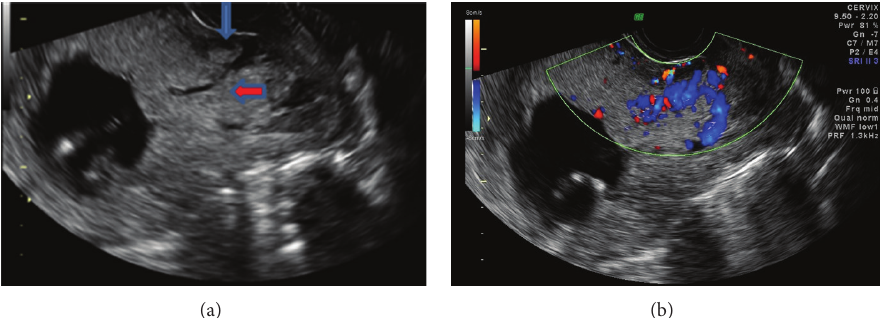
Figure 2: (a) Transvaginal scan at 13 weeks’ gestation demonstrating placental lacunae (red arrow) and loss of placental-myometrial interface (blue arrow). (b) Colour Doppler demonstration of vascular placental lacunae with turbulent